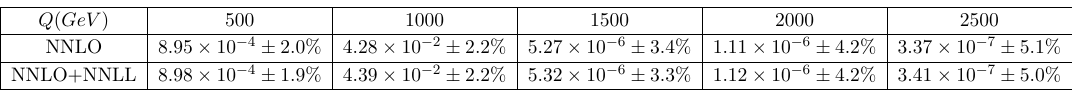
Table 1 . Intrinsic PDF uncertainties for PDF4LHC15 at 13 TeV